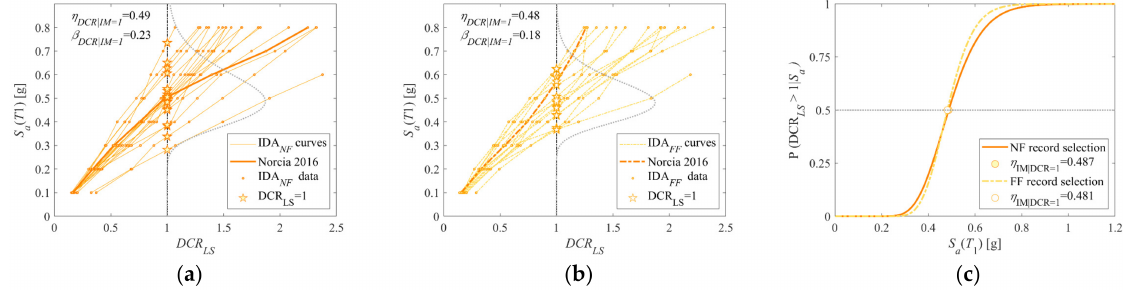
Figure 10. IDA: ( a ) comparison among IDA curves for near-fault record selection and ( b ) far-field record selection; ( c ) comparison between the two fragility curves